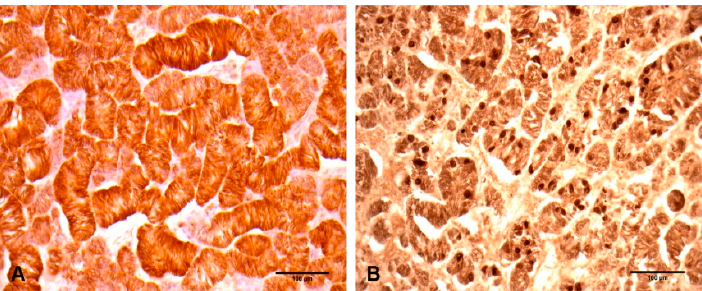
Figure 3. Immunohistochemical properties of Sertoli cell tumor isolated from the testicle of a black bear. ( A ) All tumor cells showed very strong positive reaction to vimentin immunoglobulins. Bar = 100 μ m. ( B ) Numerous Sertoli cells showed a strong positive reaction to ER- β . Bar = 100 μ